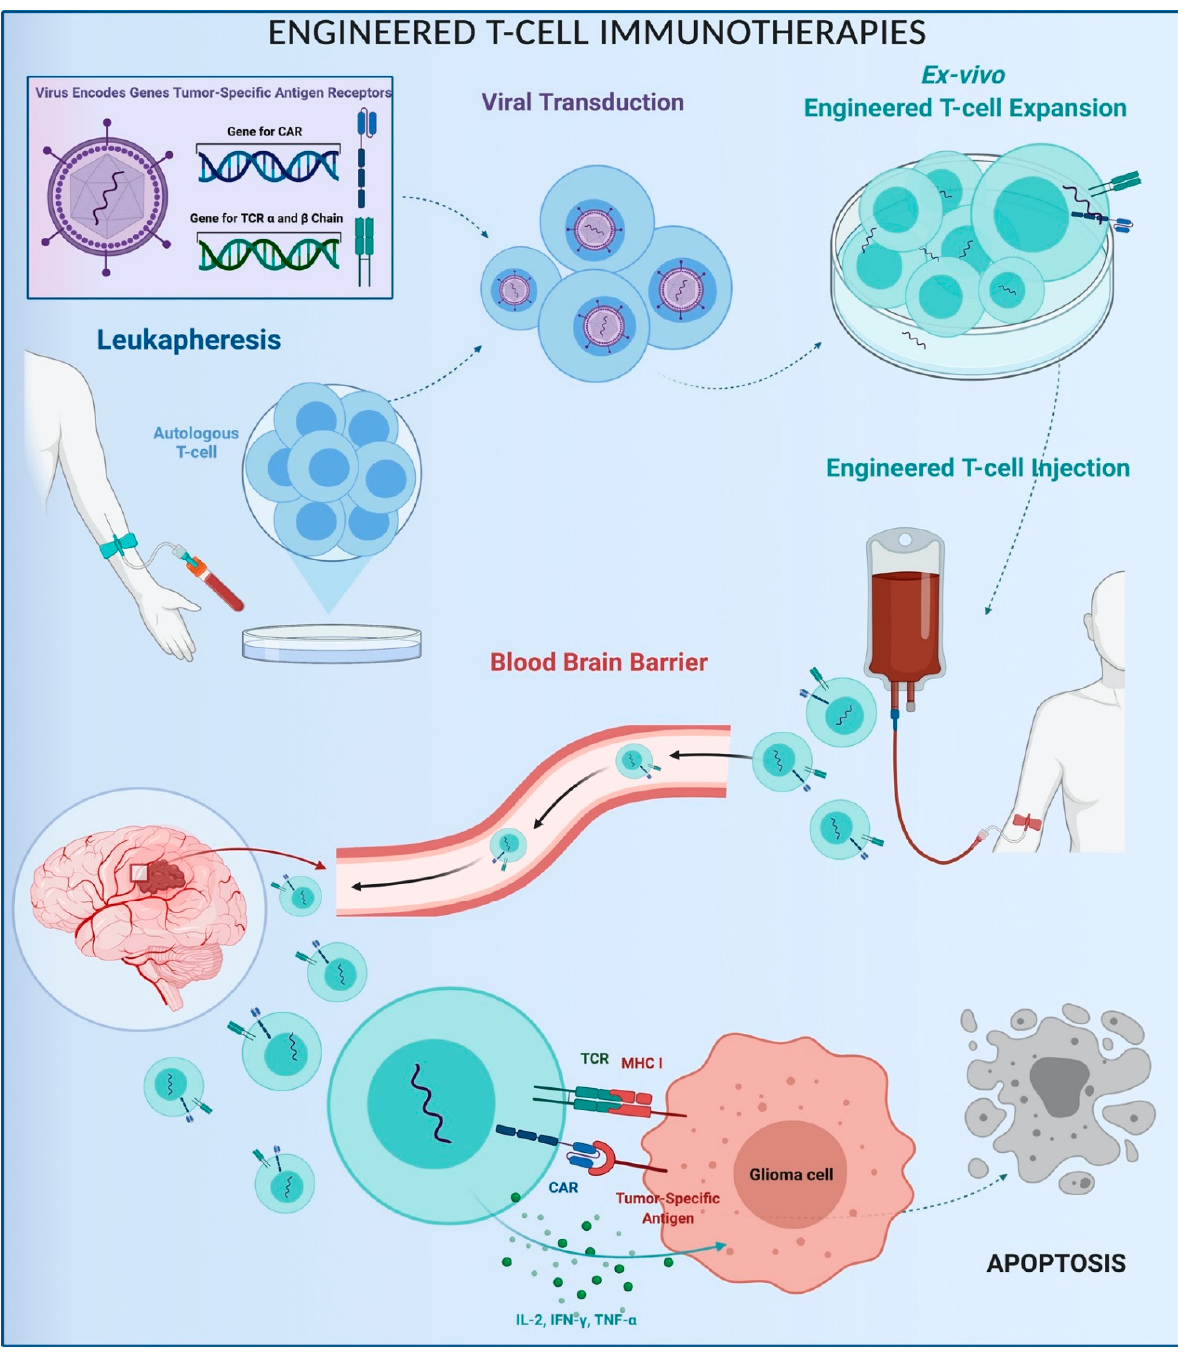
Figure 5. Schematic representation of engineered T-cell immunotherapy. CAR: Chimeric Antigen Receptor; MHC: Major Histocompatibility Complex; TCR: Transgenic T Cell Receptor.